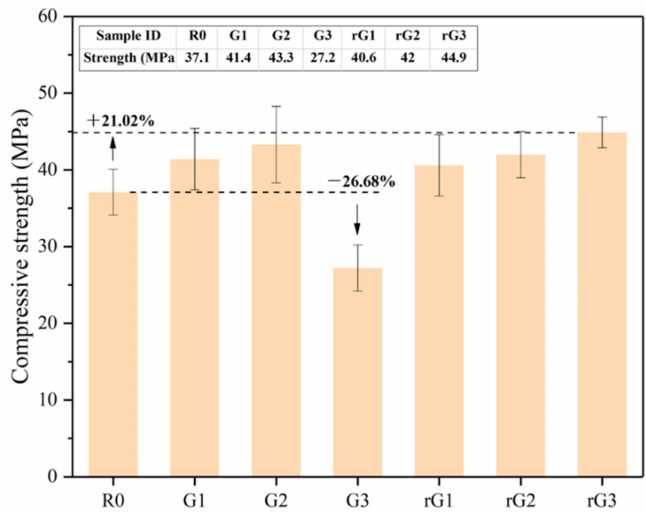
Figure 10. Compressive strength of the samples with rGO/GO